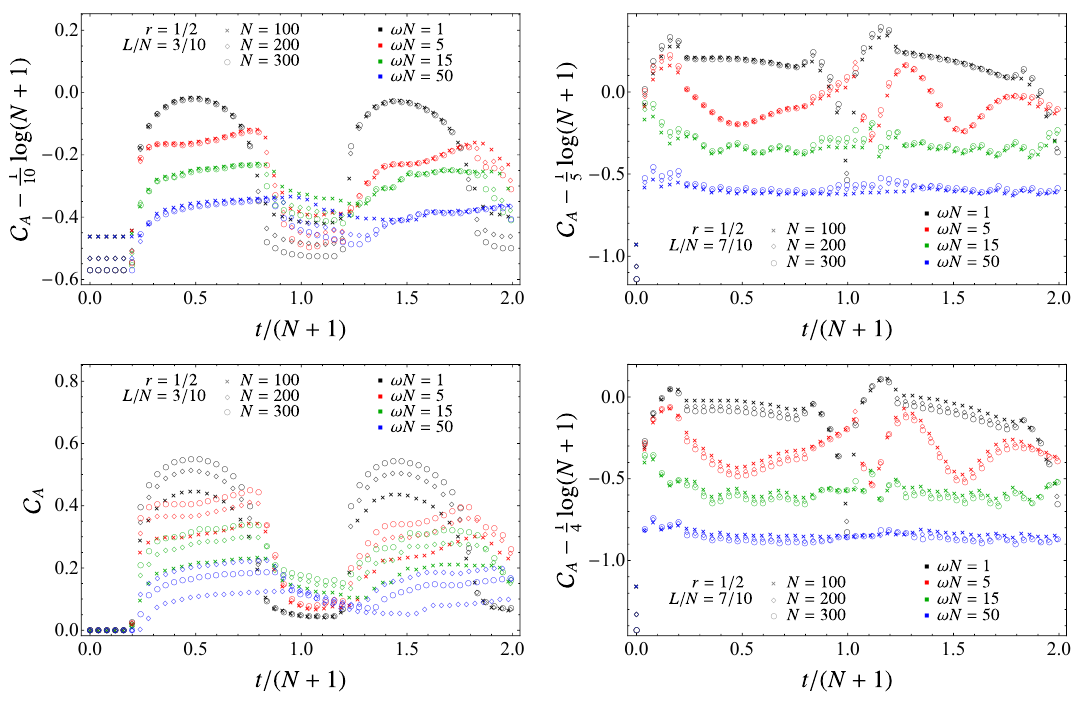
Figure 11 . Temporal evolution of the subsystem complexity C A in (4.4) for a block A made by L consecutive sites adjacent to the left boundary of harmonic chains made by N sites (see figure 1, bottom left panel) after a local quench with ω > 0 and r = 1 / 2 . The size of the blocks is fixed to a value L/N < r in the left panels and to a value L/N > r in the right